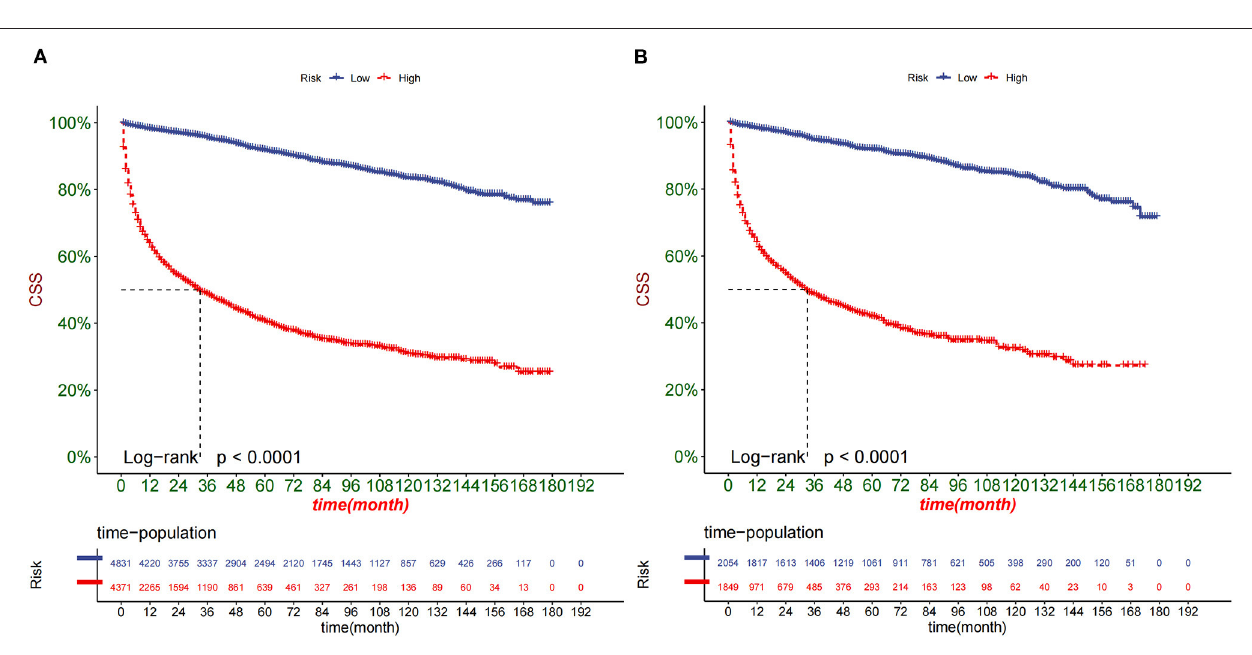
RCC is sensitive to radiotherapy, and the strategy has been agreed